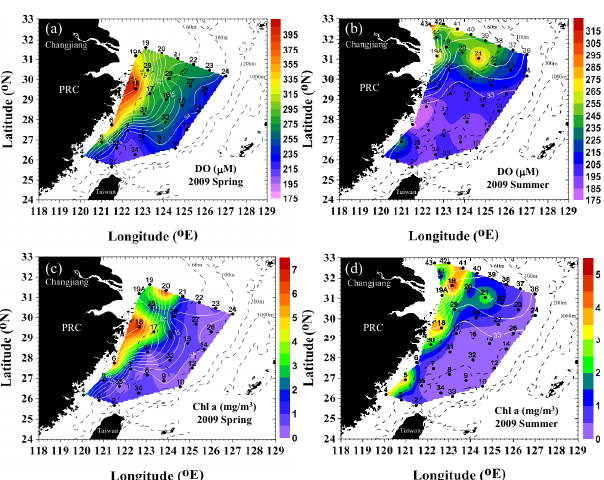
Fig. 6. Surface distributions of (a) dissolved oxygen (DO) in spring, (b) DO in summer, (c) Chl a in spring, and (d) Chl a in summer 2009 in the East China Sea. Superimposed white lines are isoha-